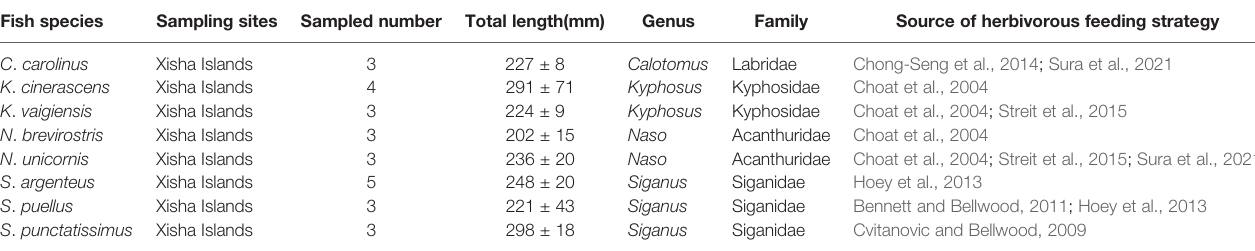
TABLE 1 | Basic information on the coral reef fi sh species sampled in this study. Fish